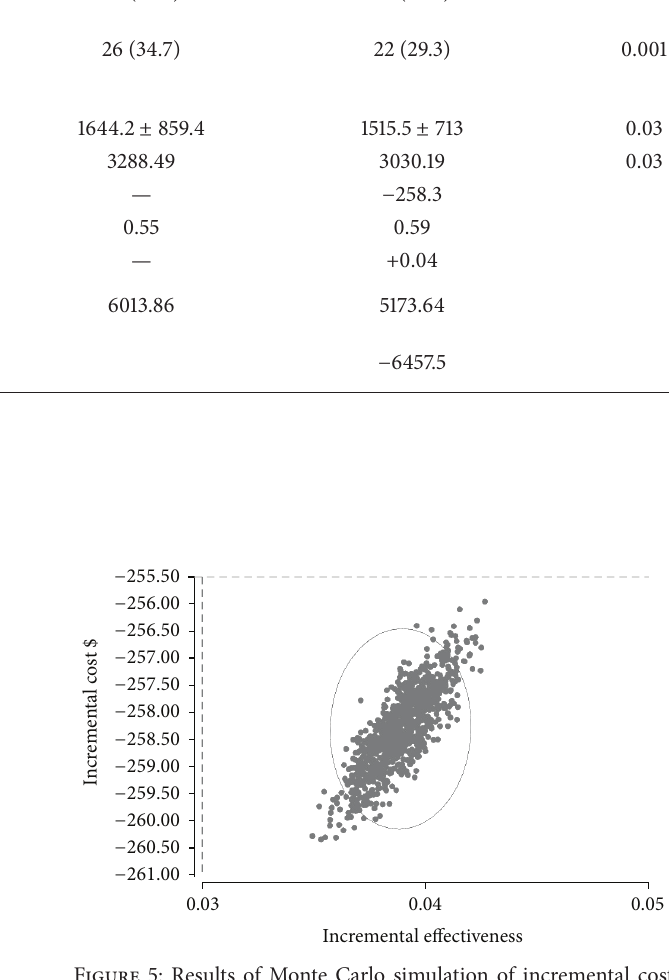
Figure 5: Results of Monte Carlo simulation of incremental cost and effectiveness scatter plot of CERA versus EpoB, based on 50000 random iterations of cost-effectiveness